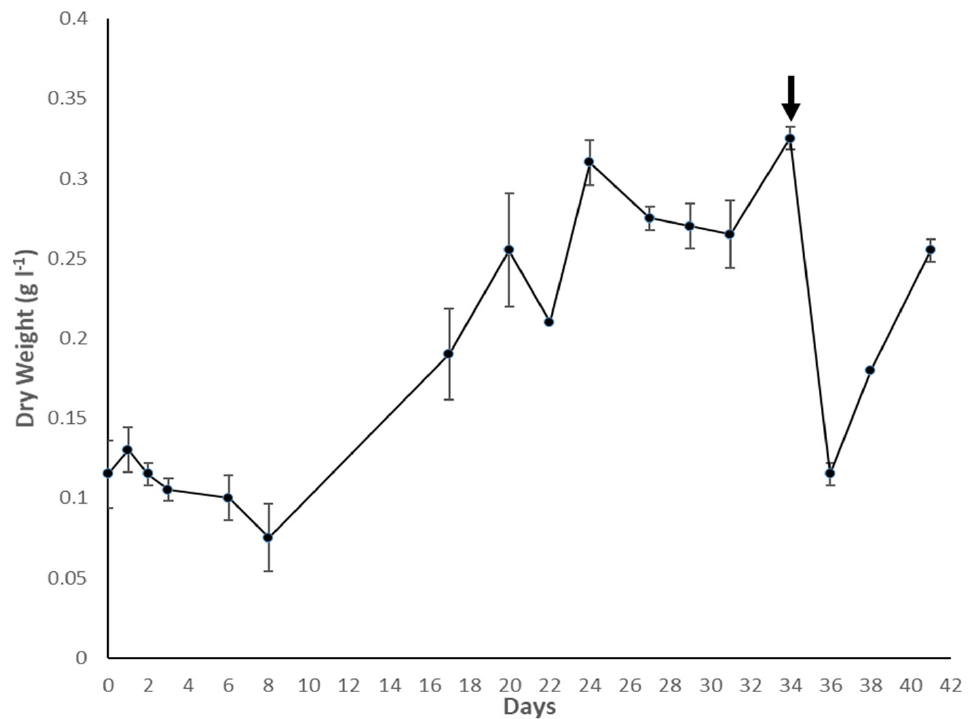
Figure 2. Growth curve as dry weight of C. fritschii in the PBR. Error bars represent standard deviation. The black arrow indicates the time point at which the biomass was harvested.